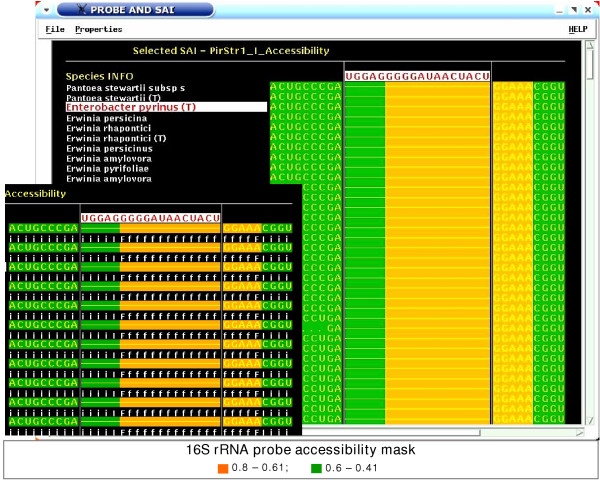
Probe visualization window. Probe visualization window displaying local alignments of probe target regions for members of the target group. Column statistics performed on the sequence alignments and structure masks are visualized in different background colors in the probe visualization window. This screenshot shows 16S rRNA accessibility map, where the experimentally determined relative fluorescence intensities are visualized in different colors (orange (0.8 – 0.61); green (0.6 – 0.41) [11]).